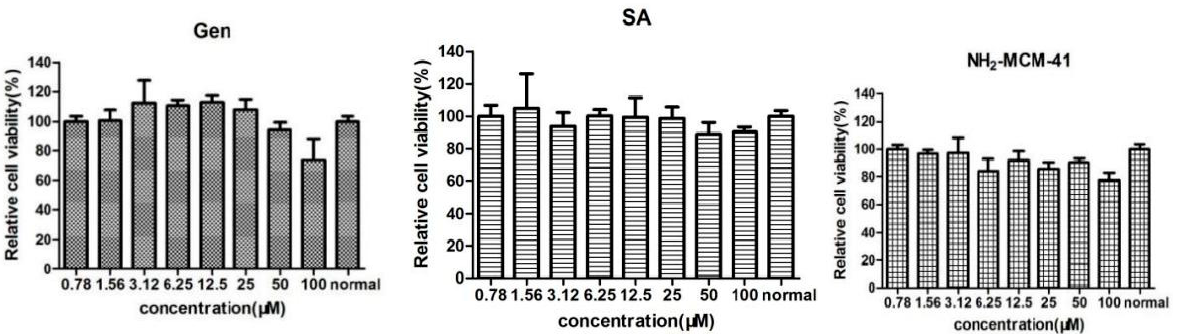
Figure 13. The effects of NH 2 -MCM-41, SA and Gen on the activity of Caco-2 cells.